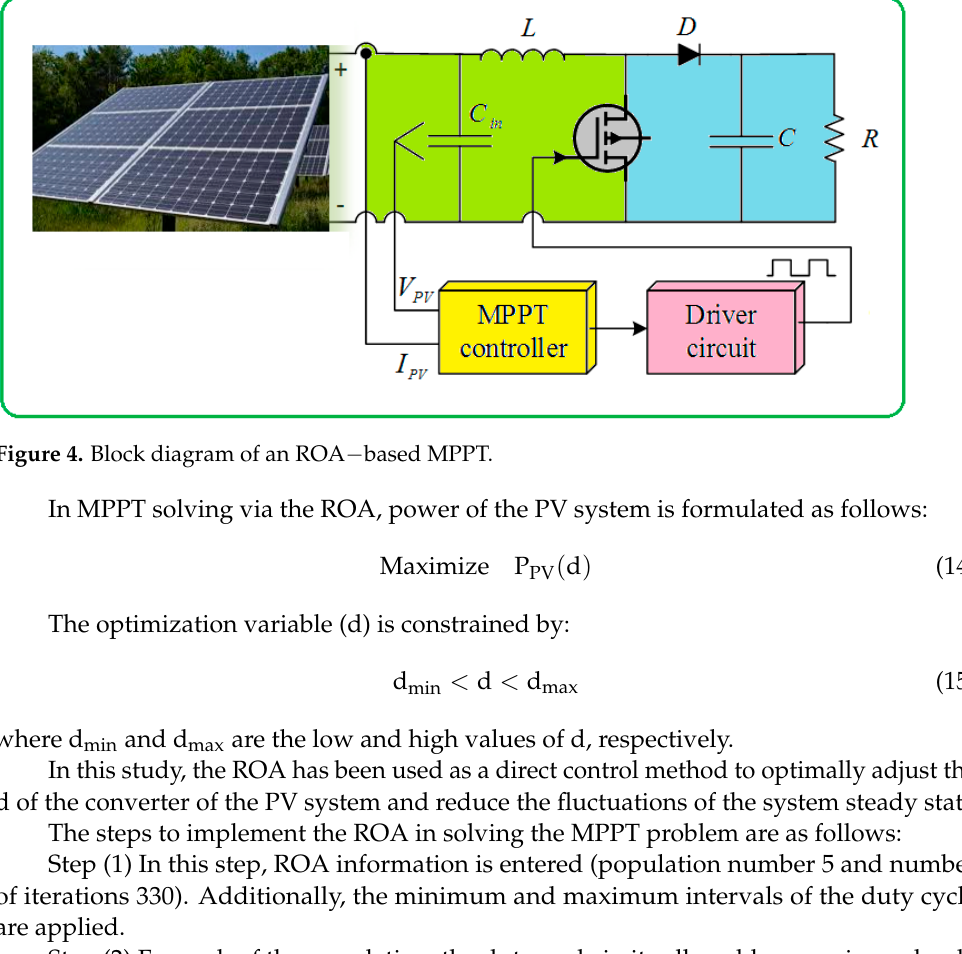
8 of 22 Algorithm 1 Pseudo-code of the ROA 1: Initiate the population and memory location R i and R pre ; 2: Initiate the R Best as optimal solution and f(R Best ) as its optimal fitness; 3: While t < T do 4: